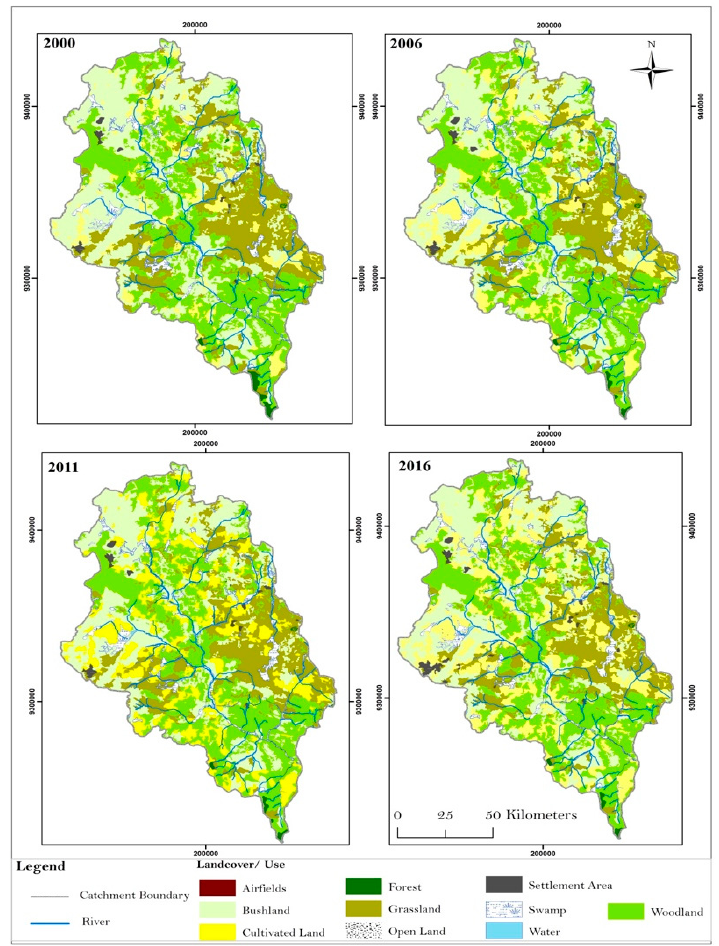
Figure 3. LULC maps for 2000, 2006, 2011, and 2016 at Kinyasungwe Sub-catchment (upstream). Table 7. Transition matrix showing LULC change in Kinyasungwe Sub-catchment between 2000–2016. Table 7 indicates the areas changed with their corresponding percentages based on the change matrix cross-tabulation from 2000 to 2016. In the table, the LULC class is compared to another in terms of total area LULC class. During the study duration, no changes of settlement area were observed, as 100% remained intact, followed by cultivated land at 96%, woodland at 91%, swamp at 81%, grassland at 78%, bushland at 76%, forest at 50%, and water at 32%. Therefore, the highest conversion was experienced in the water area, as almost 65% of the total area was converted to swamp and the rest was converted to cultivated land (2%) and woodland (1%). Most of the forest was converted to woodland (42%) and grassland (5%). Although the cultivated land did not change much, almost 23% was gained from bushland (1298.03 km 2 ) followed by grassland (667.45 km 2 ), woodland (404.98km 2 ), swamp (42.63), forest (1.15km 2 ), and water (0.60km 2 ). Between 2000 and 2016, swamp